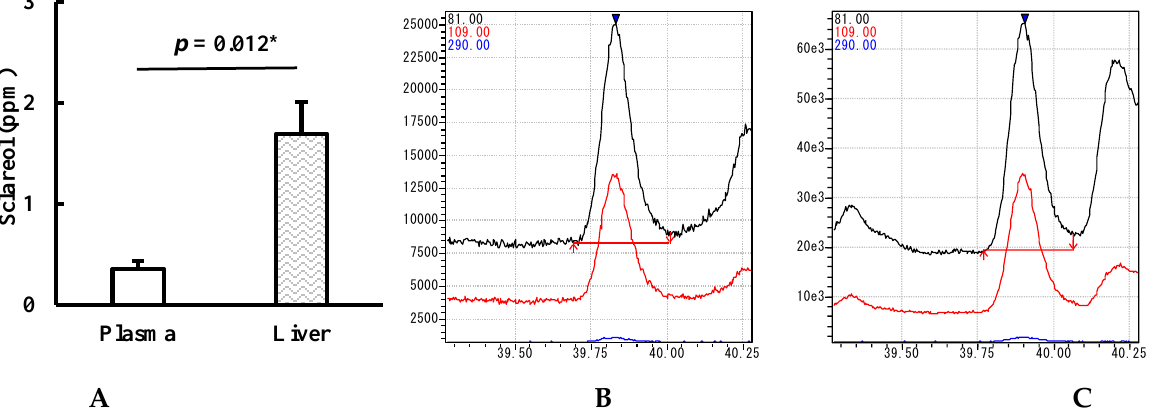
Table 1. GC-MS analysis of sclareol concentrations in the plasma and liver. Control ( n = 6) Jojoba ( n = 6) Sclareol ( n = 4) Plasma sclareol concentration (ppm) N.D. N.D. 0.36 ± 0.08 Liver sclareol concentration (ppm) N.D. N.D. 1.69 ± 0.32 * Values are mean ± SE. N.D., not detectable. Control, naïve control group ( n = 6); Jojoba, jojoba oil-administered group ( n = 6); Sclareol, sclareol-administered group ( n = 4). * p < 0.05, compared with the plasma sclareol concentration in the sclareol-administered group.